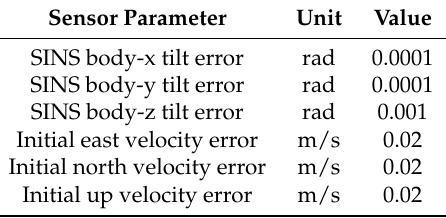
Table 3. Initial